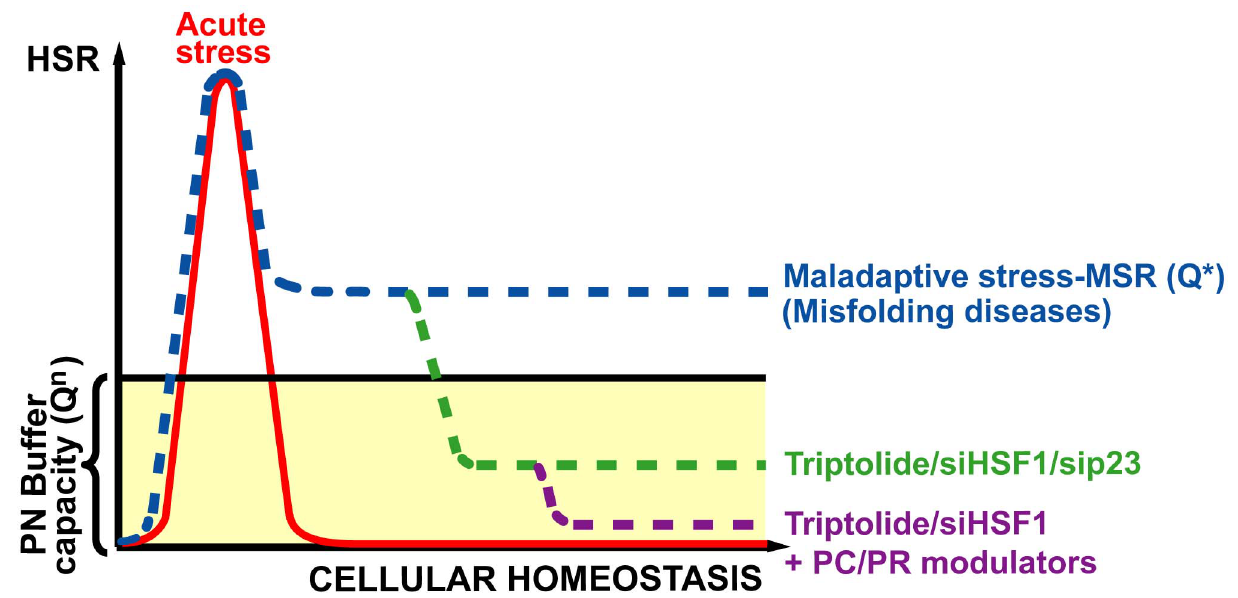
Figure 8. Q-state management of MSR to correct human disease. Illustrated is the activation state of the HSR in response to acute stress (red) or to the MSR (blue) seen in disease. Acute HSR activation, seen during acute stress insults, protects from and/or corrects misfolding and rapidly returns to basal levels, allowing normal biology to resume. In misfolding disease, chronic activation of the HSR alters the normal, physiologic Q-state (Q n ) because of the continued expression of misfolded protein. Once chronically elevated (Q*), the folding environment becomes maladaptive as it fails to return to the Q n (light yellow area). Down-regulation of the MSR by siHSF1, sip23, or triptolide promotes a reduction of the Q*, which now falls within the proteostasis buffering capacity (green line), promoting a more normal cellular folding environment. This effect can be further improved (purple line) when combined with protein fold correctors (pharmacologic chaperones; PCs) which impart improved thermodynamic stability to the fold, or proteostasis regulators (PRs) that improve protein Q-state biology, improving function of disease-related misfolded protein and its proteome’s associated environment, promoting abrogation of the chronic stress and improving health.